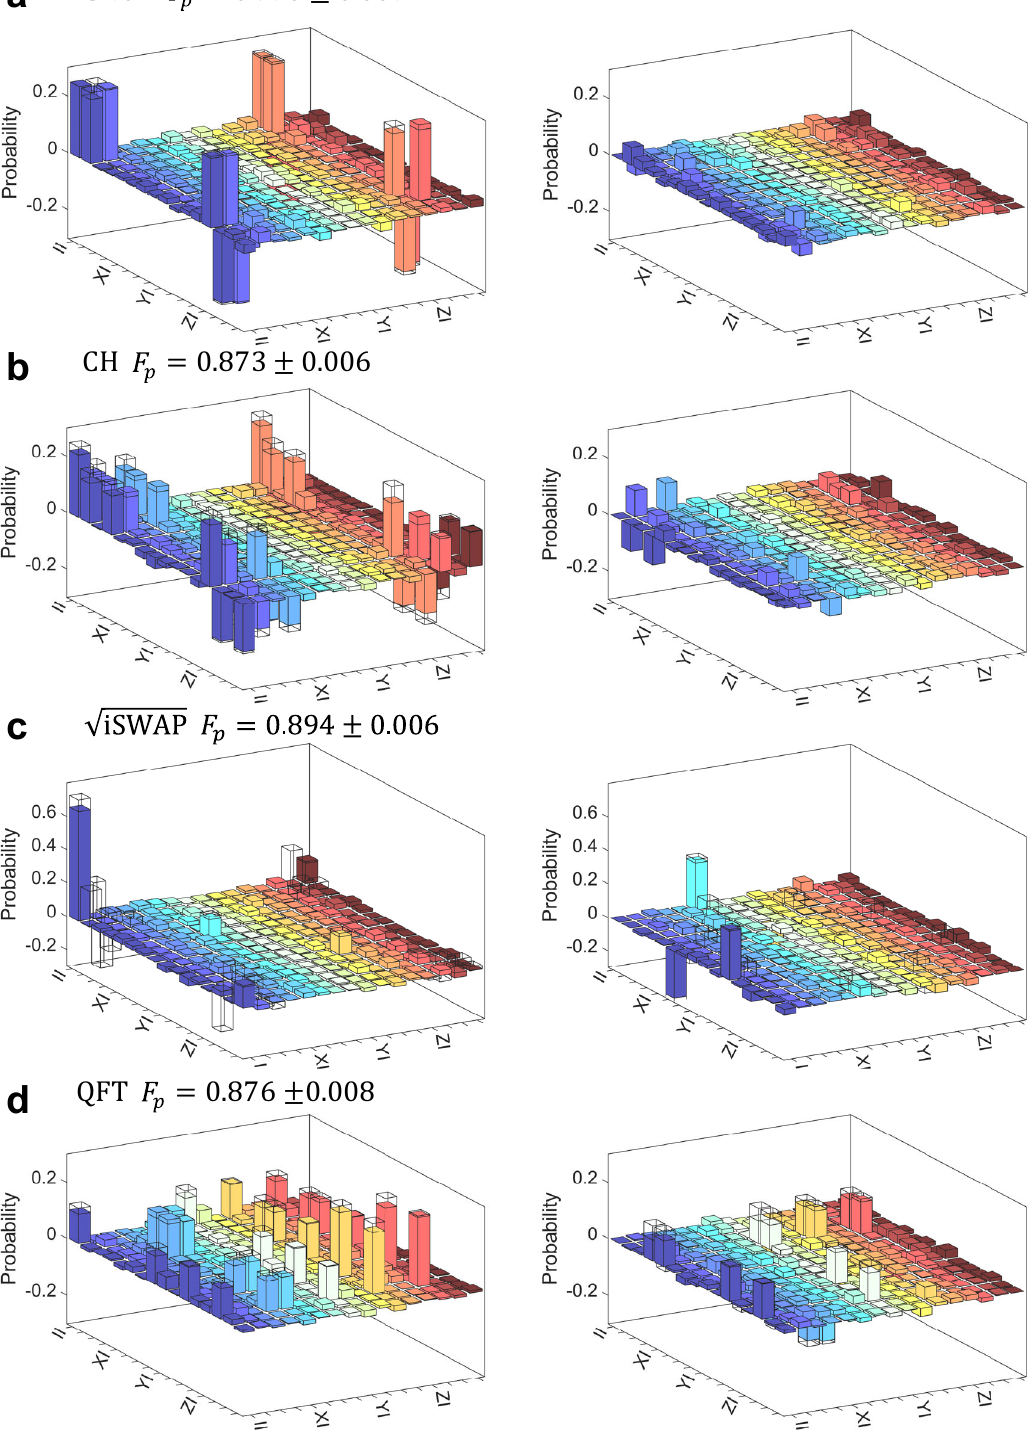
Fig. 4 Experimental results of quantum process tomography for a diversity of two-qubit quantum logic gates. CNOT gate ( a ), CH gate ( b ), ffiffiffiffiffiffiffiffiffiffiffiffiffi p iSWAP gate ( c ), QFT gate ( d ). The left and right parts are the real and imaginary parts of the quantum process tomography matrices. The fi delity errors are calculated with a 1000-times Monto Carlo simulation subjected to Poissonian